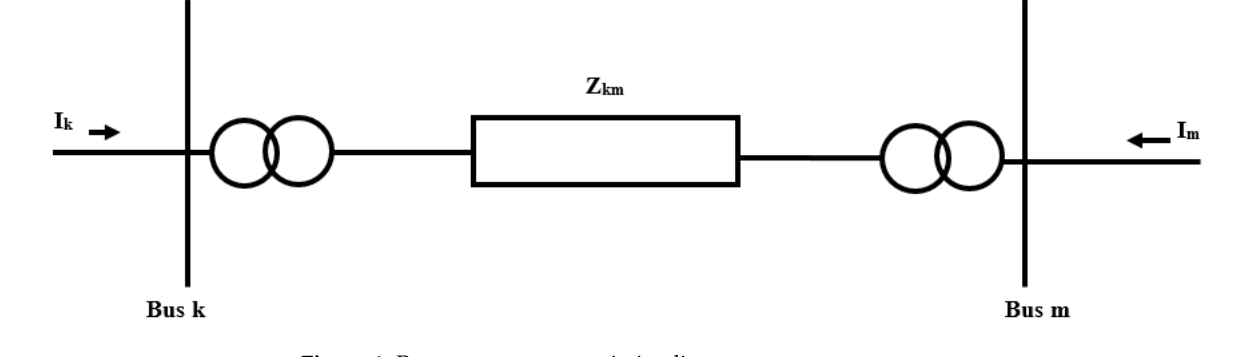
Figure 1. Power system transmission line.